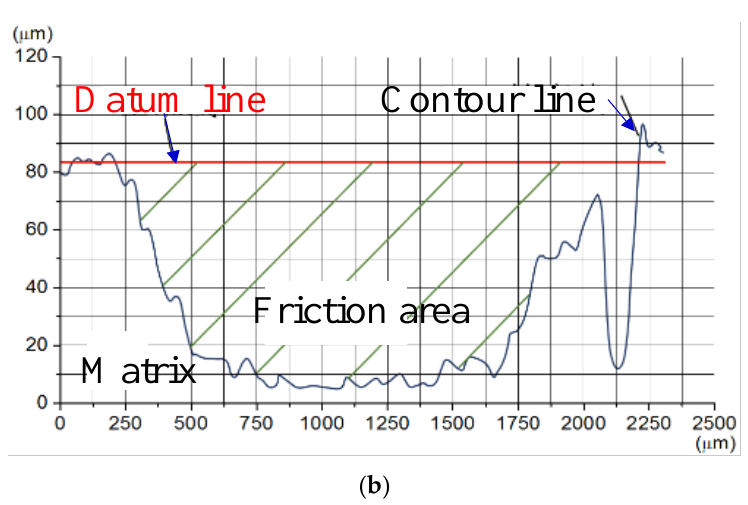
Figure 5. Image of the wear trace contour: ( a ) interception of grinding marks by the contour graph; and ( b ) calculation of the wear scar cross-section area by dividing the meshed region.